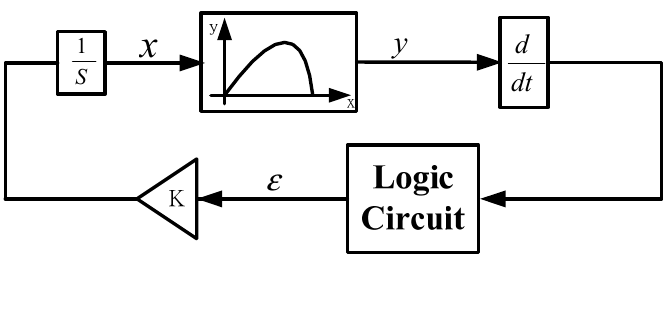
Figure 6. Extremum seeking control (ESC)